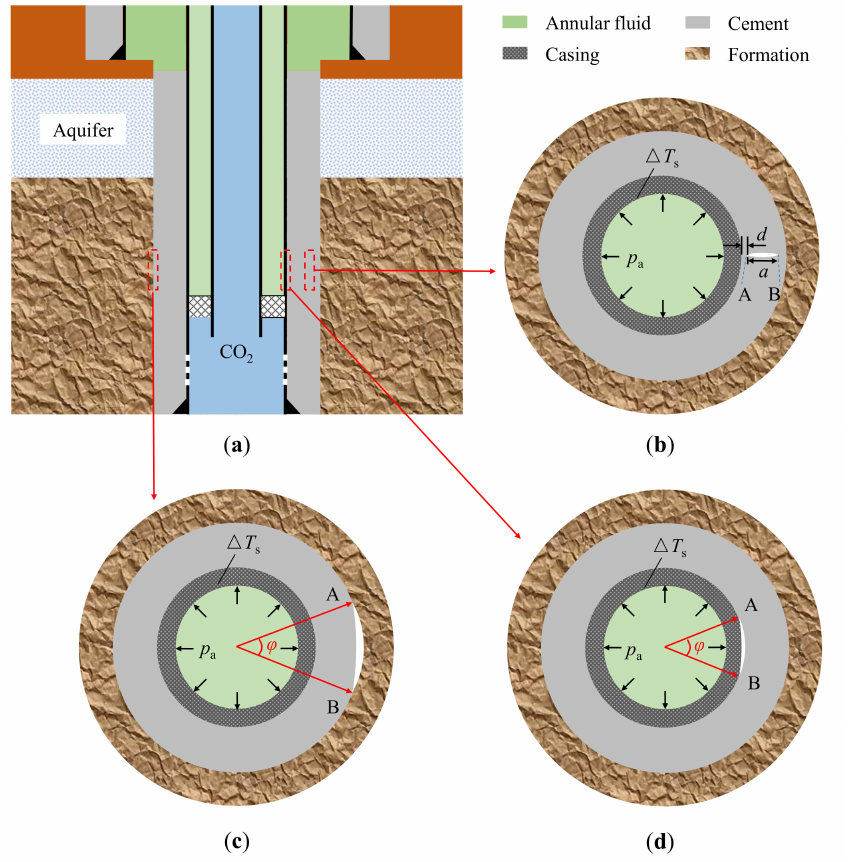
Figure 1. The schematic of a vertical injection well with defects in the wellbore barriers: ( a ) the vertical wellbore; ( b ) a radial crack in the cement; ( c ) an arc crack at the casing-cement interface; ( d ) an arc crack at the cement-formation